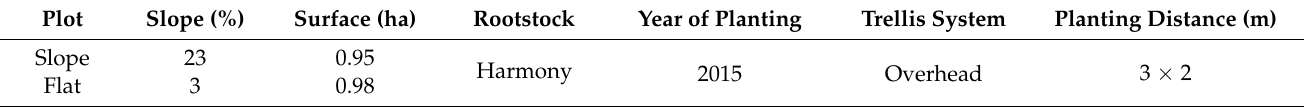
Table 1. Main characteristics of the table grapes under study. Plot Trellis System Planting Distance